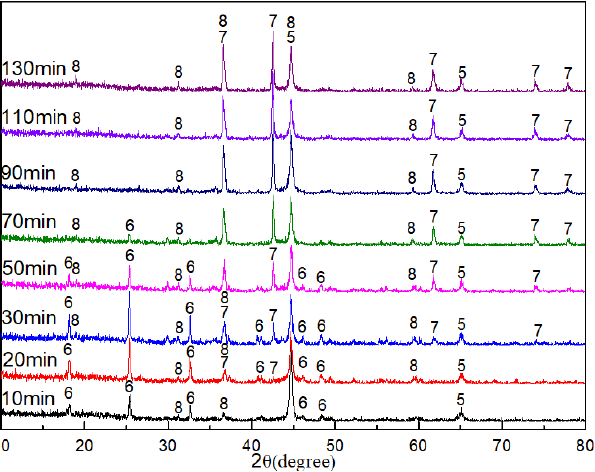
Figure 3. 5—iron (Fe); 6—M 3 O 5 (FeTi 2 O 5 ; MgTi 2 O 5 ; Ti 3 O 5 ); 7—osbornite (TiN); 8—spinel (MgAl 2 O 4 ). XRD patterns of pellets roasted at 1300 ◦ C for different amounts of time.